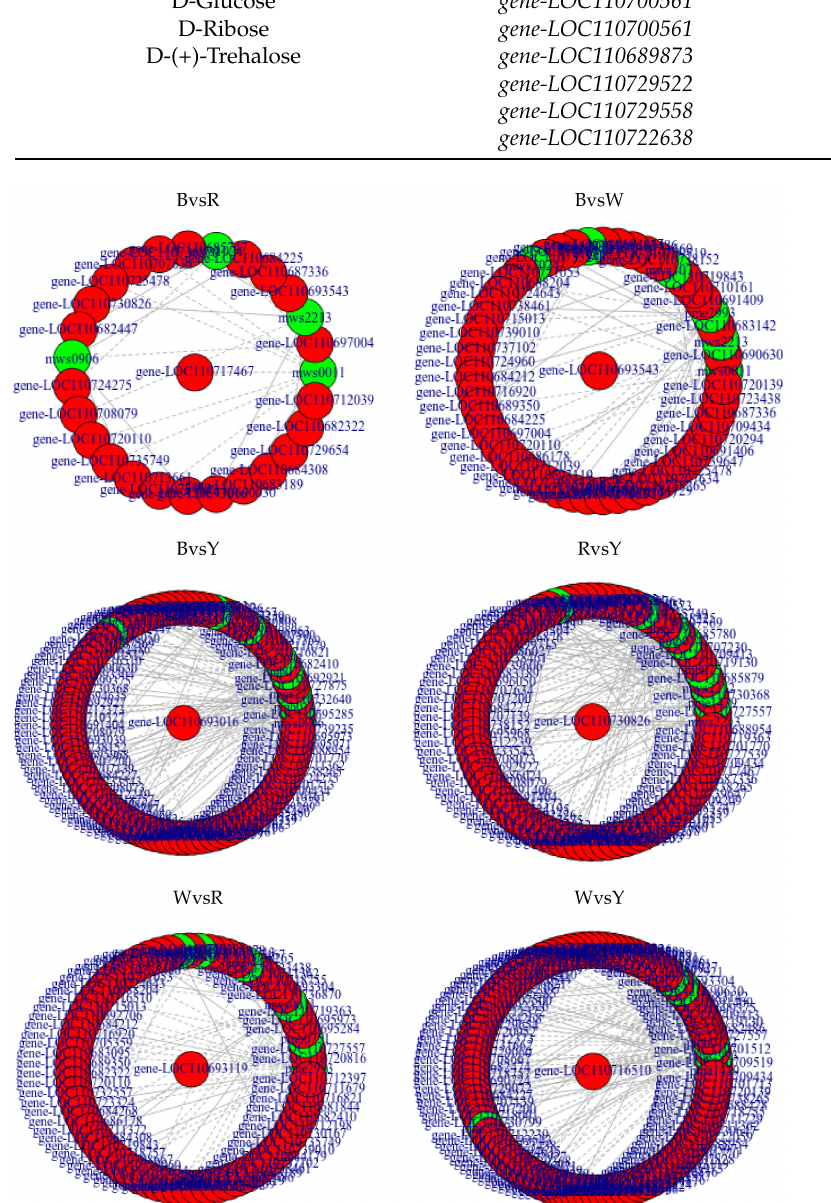
Figure 3. Network diagram of differential genes and metabolites among cultivars of phenylpropane biosynthesis pathway. Note: Red circles represent genes; green circles represent metabolites; solid lines are positively correlated; dotted lines are negatively